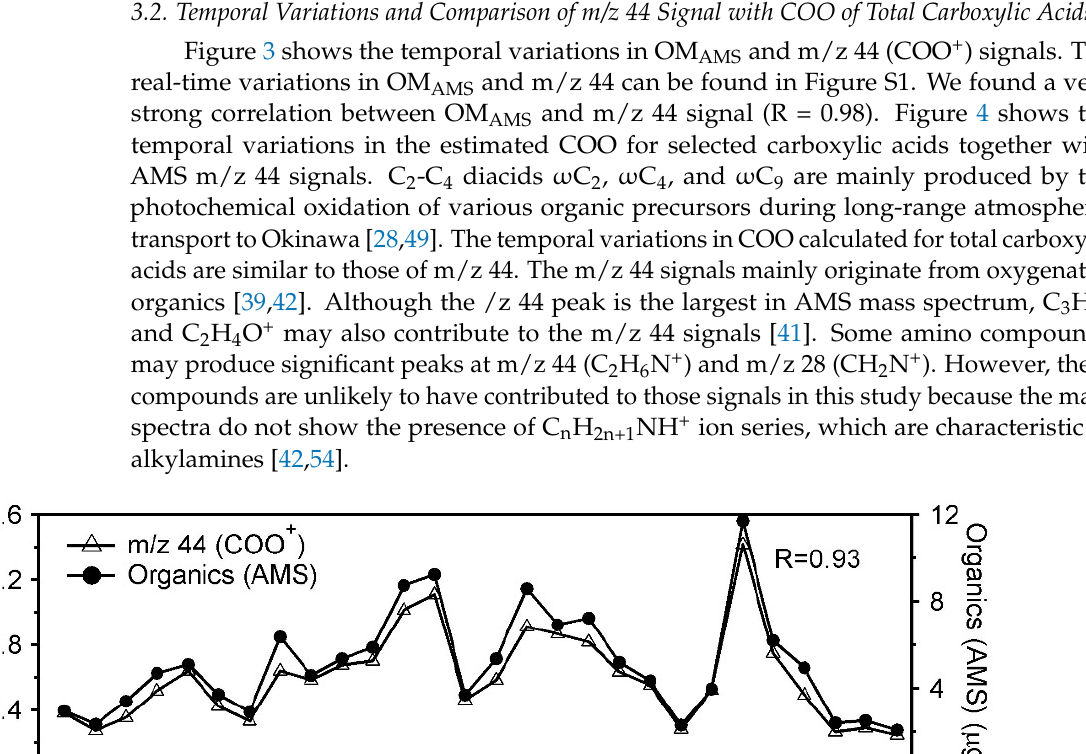
Figure 2. Averaged relative abundances of total diacids, total oxoacids ( ω C 2 – ω C 9 and pyruvic acid), benzoic acid, and fatty acids (C 7 –C 20 ) in total carboxylic acids detected in the Cape Hedo aerosols (PM 1.0 ).